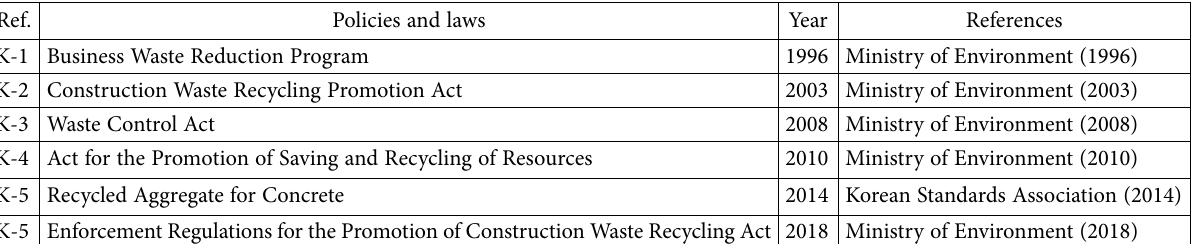
Table 10. Existing policies and laws on C&D waste management in South Korea